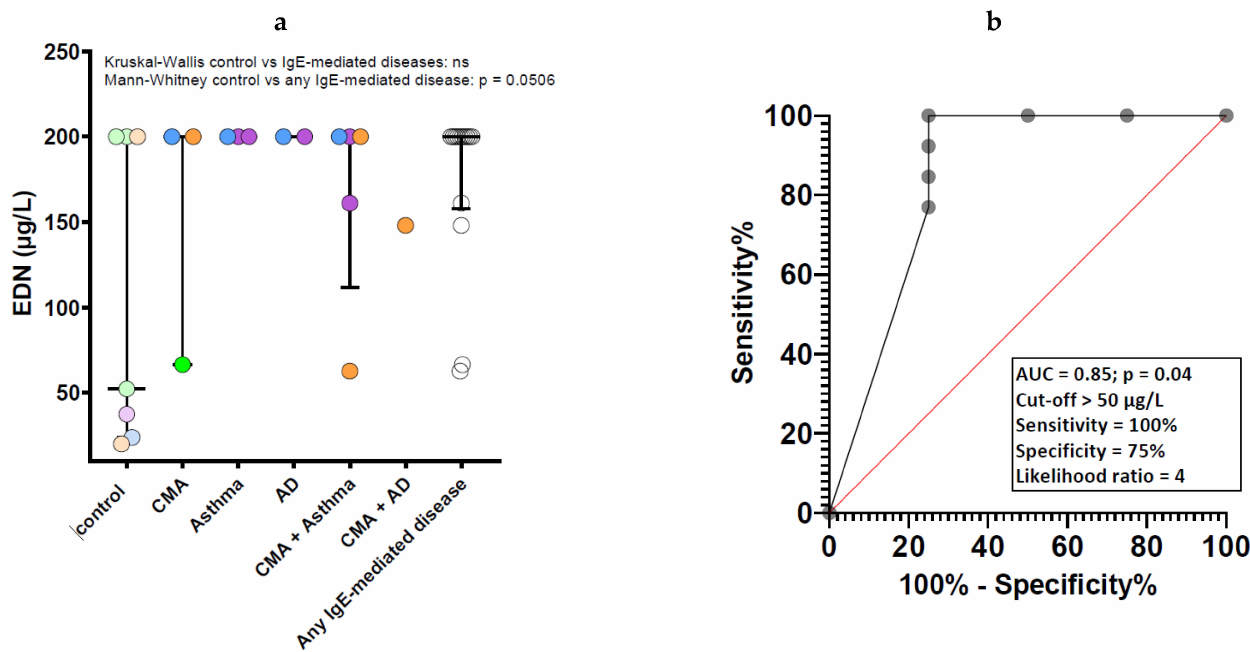
Figure 6. Fecal EDN concentration in neonatal fecal samples. ( a ) EDN was detectable in all samples, with a non-significant increasing trend in patients who developed IgE-mediated diseases during the 1st year of life; ( b ) An ROC analysis shows that a cut-off value of 50 µ g/L EDN in fecal samples taken between 2 and 14 weeks predicts IgE-mediated diseases during the 1st year of life with a sensitivity of 100% (CI95%: 77–100%) and a specificity of 75% (CI95: 30–99%); p = 0.04. The colors denote the age at which the samples were taken (green: meconial; blue: 2–5 weeks; purple: 6–8 weeks; orange: 9–14 weeks), with the light shades denoting the control subjects and the dark shades denoting the patients who developed IgE-mediated diseases by the age of 1. AD, atopic dermatitis; CI, confidence interval; CMA, cow’s milk